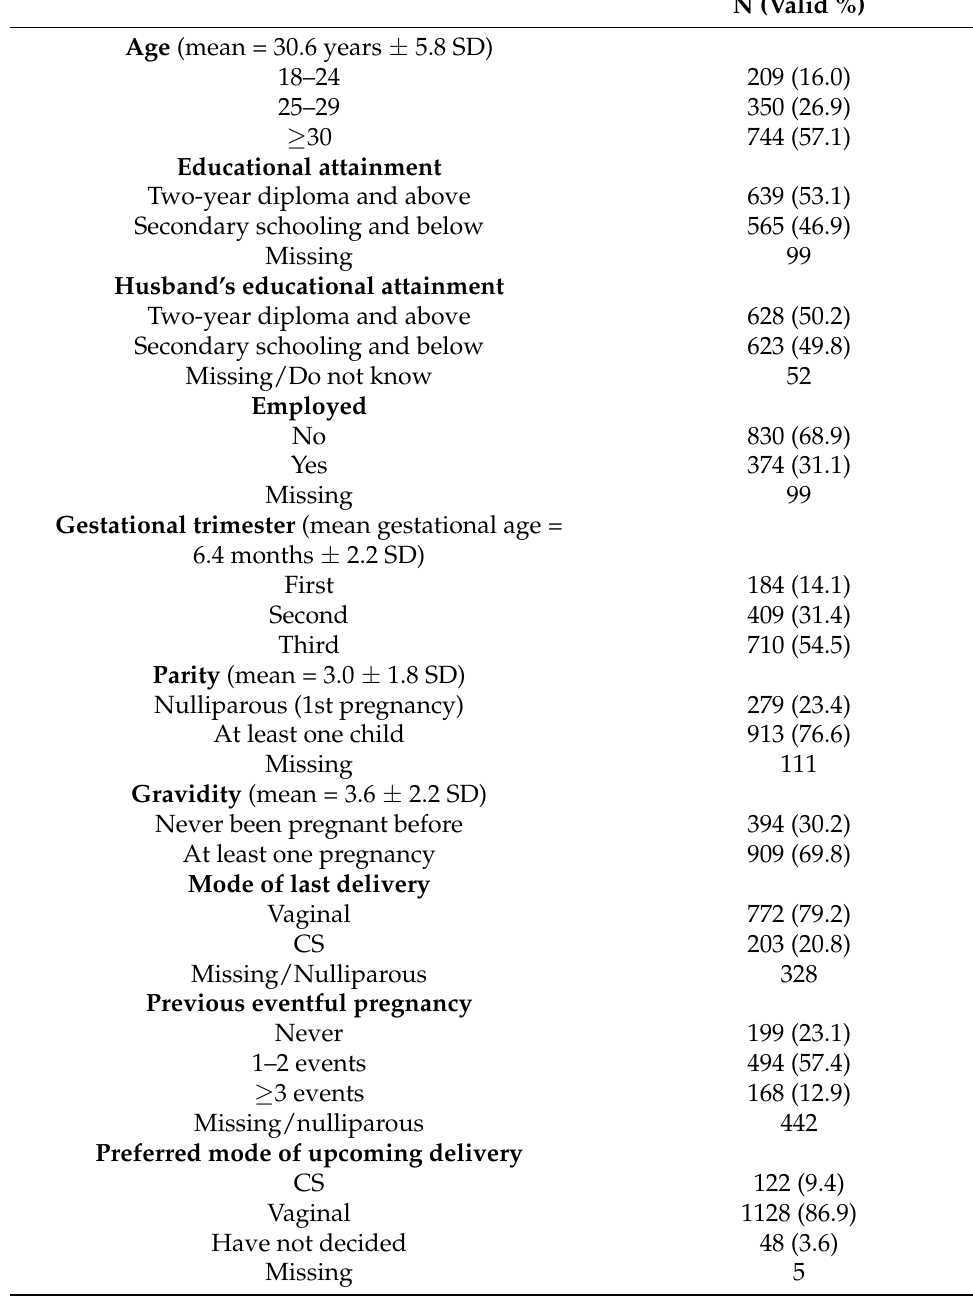
Table 1. Sociodemographic and maternal characteristics of pregnant women (N =